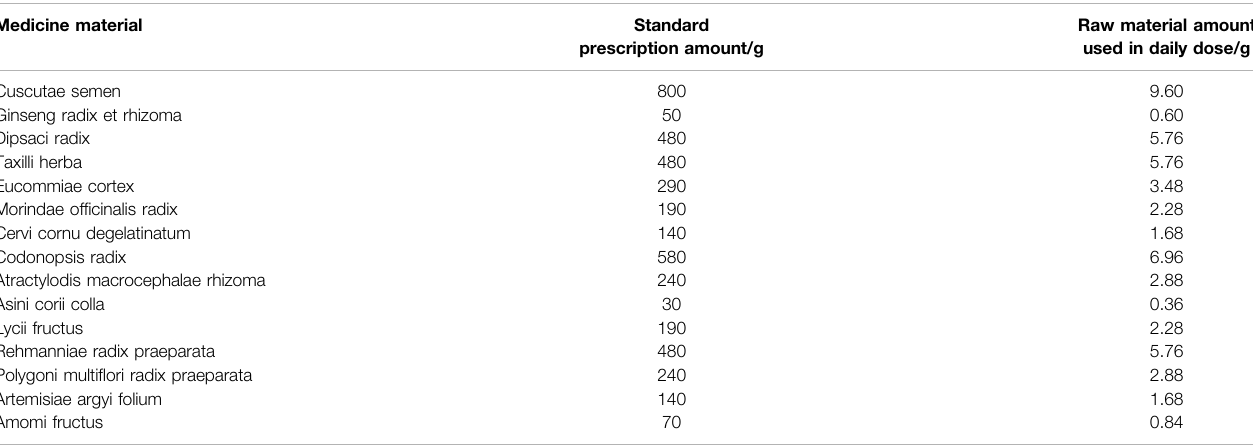
TABLE 1 | Standard prescription of ZYP and raw material amount used in daily dose.